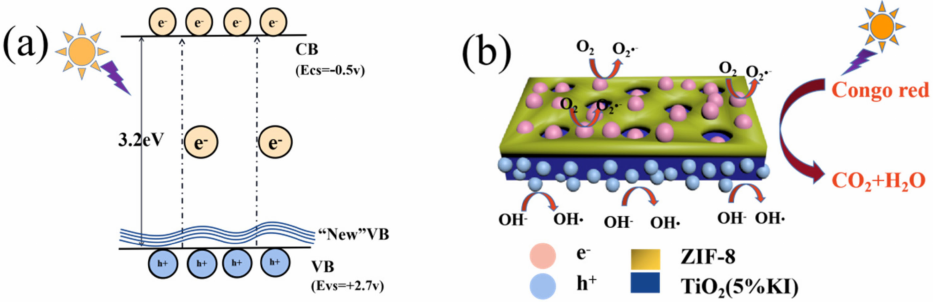
Figure 7. Schematic of the photocatalytic mechanism of ( a ) TiO 2 (KI) and ( b ) ZIF-8@TiO 2 (5%KI). The catalysts used were TiO 2 (350 ◦ C), TiO 2 (2%KI), TiO 2 (5%KI), TiO 2 (10%KI), TiO 2 (15%KI), TiO 2 (30%KI) and ZIF-8@TiO 2 (5%KI). The dosage of the catalyst was 20 mg. A concentration of 20 mg/L and a volume of 100 mL of Congo red solution were selected for the photodegradable material. The test process was the same as that given in 2.2.3,